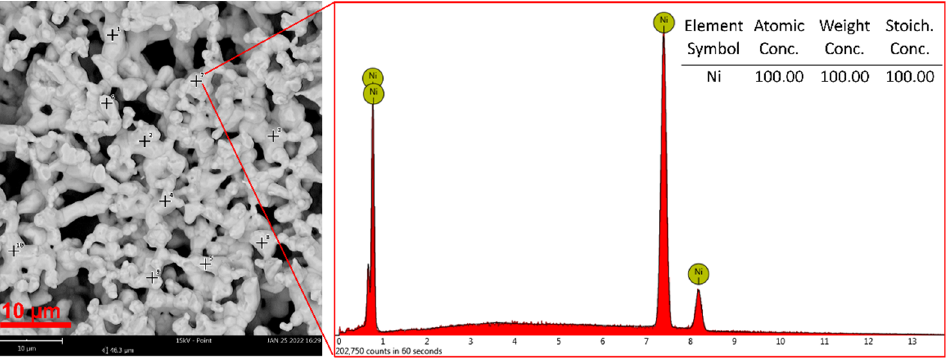
Figure 10. SEM image and representative EDS spectrum for PVB-Ni 25% print after heat treatment.